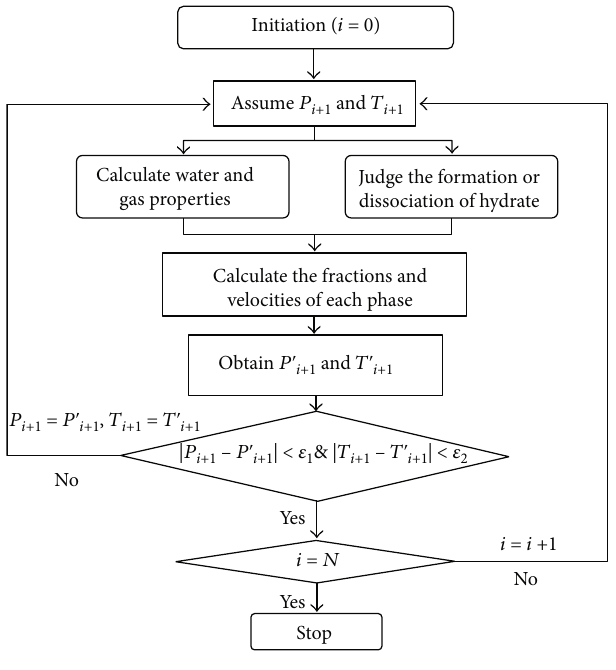
Figure 2: Calculation work fl